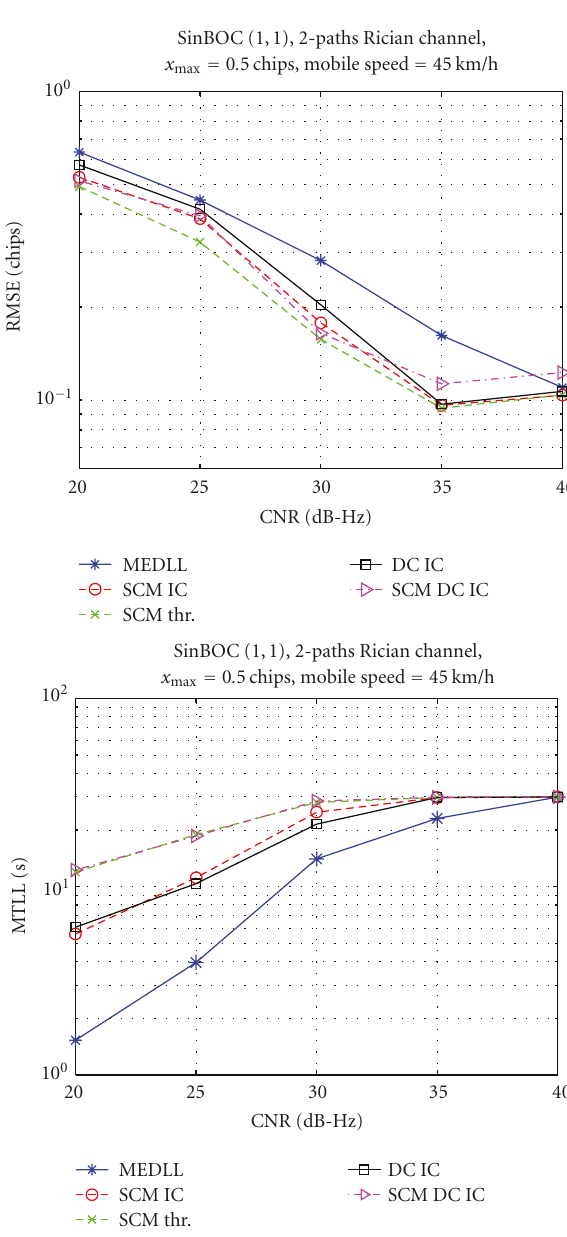
Figure 23: Comparison of feedforward delays estimation algo- rithms employing the MEDLL and IC methods and of the SCM with threshold approach, as a function of CNR; SinBOC(1,1) modula- tion, 2-paths decaying PDP Rician channel, v = 45 km/h, x max = 0 . 5